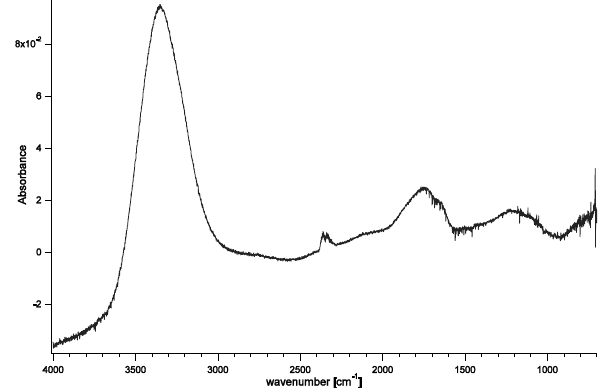
Fig. 9. IR absorption spectrum of an amorphous HCl–ice film ob- Figure 9. IR absorption spectrum of an amorphous HCl/ice film obtained by deposition of a HCl/H 2 O tained by deposition of a HCl–H 2 O 1:10 mixture at 1:10 mixture at 180 K.